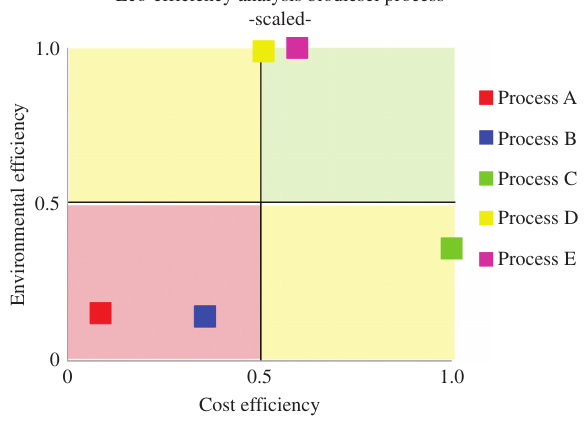
Figure 13 Eco-efficiency ranking of different biodiesel process alter- natives utilizing waste oil (Process A: pretreated alkali-catalyzed; Process B: acid-catalyzed; Process C: heterogeneous acid-catalyzed; Process D: supercritical process, all published by West et al. [42] and Process E: supercritical process developed within CoPIRIDE) ranked according to their environmental and cost efficiency.